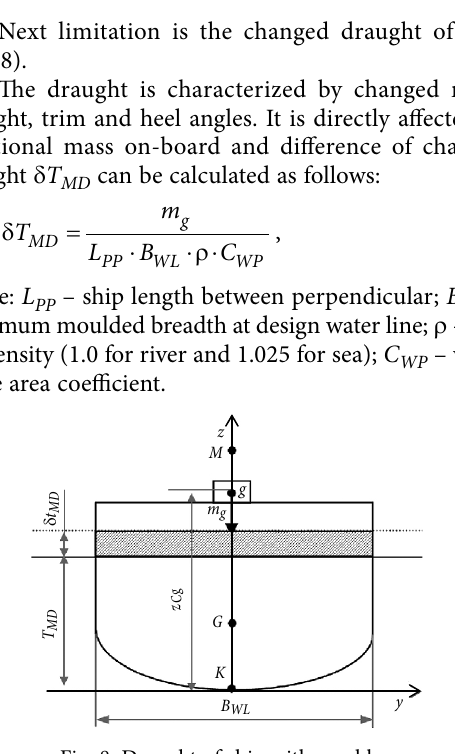
Fig. 8. Draught of ship with scrubber Fig. 9. The heel of ship with